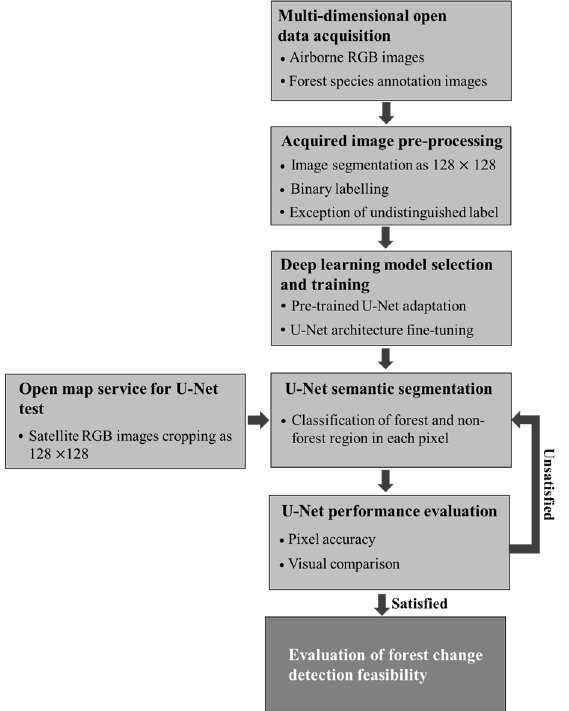
Figure 1. Research overview for evaluating feasibility of forest change detection by using deep learning model training with open source